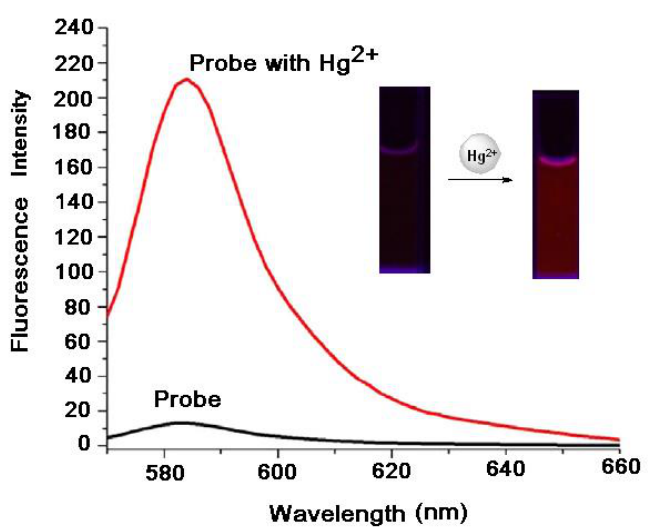
Figure 2. Fluorescence spectra of VRF probe (10 μ M) in the absence and presence of Hg 2+ (100 μ M) in CH 3 CN/HEPES buffer solution (1:1, v / v , 0.1 M, pH 7.4); excitation wavelength = 560 nm, the spec- trum was acquired 60 min after HgCl 2 addition at 25 °C. Inset: fluorescence colour change observed spectrum was acquired 60 min after HgCl 2 addition at 25 ◦ C. Inset: fluorescence colour change under UV light at 365 nm. observed under UV light at 365